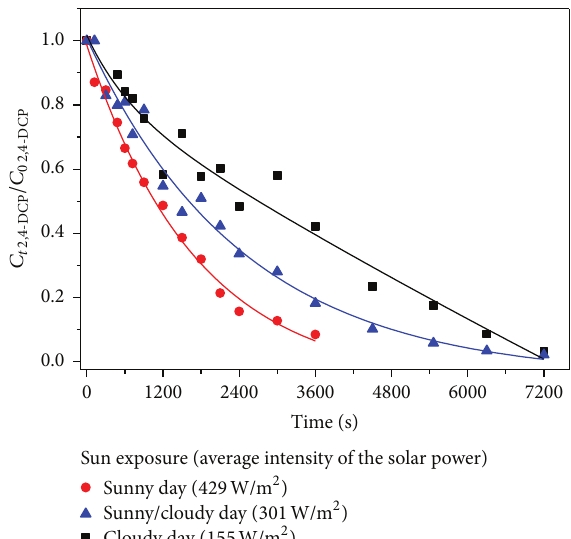
Figure 8: Variation in the concentration of 2,4-DCP during pho- Figure 7: The dependence of 2,4-DCP relative concentrations decay todegradation experiments mediated by TPPS 4 and without TPPS 4 = 2.4 × 10 −4 M, 𝐶 0 TPPS = 2 × under various sun insolation ( 𝐶 02,4 and induced by solar and lamp radiation. Insert: incident energy - DCP 4 10 −5 M, pH = 7, air bubbling, and natural sunlight irradiation). ( 𝐸 0 ) of radiation for sunlight and lamp and energy absorbed ( 𝐸 a ) by TPPS 4 .